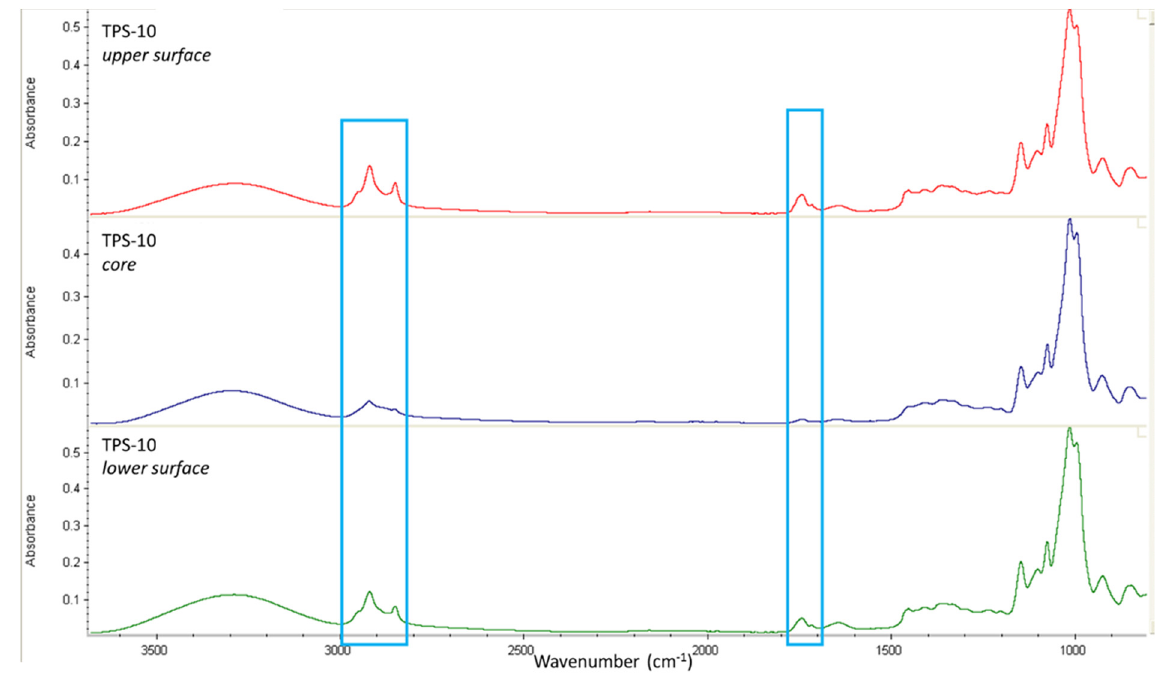
Figure 5 . FTIR spectra for TPS-10 (upper surface, core and lower surface).